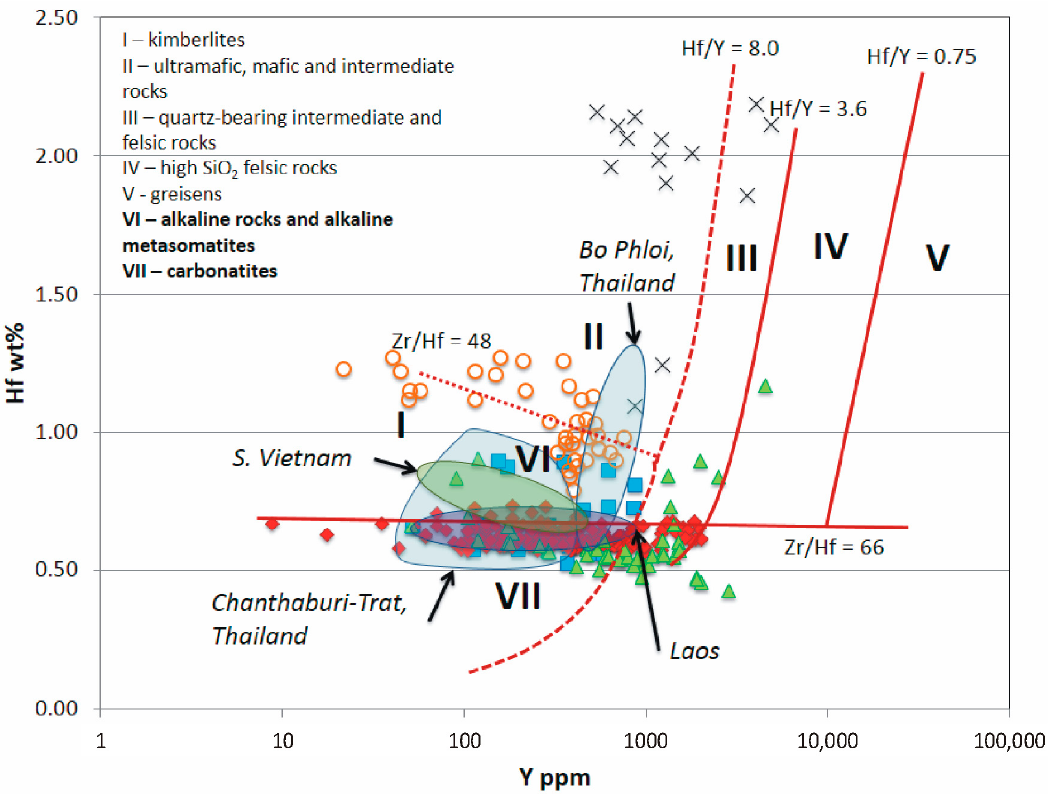
Figure 11. Y versus Hf discrimination diagram for RVP zircon, zircon xenocrysts from ZIP localities, and zircon inclusions in corundum (modified after [92]). Red diamonds: RVP zircon, blue squares: Pailin, Cambodia (Piilonen, unpublished data), blue field: Thailand (Piilonen, unpublished data), green triangles: Australia [11], orange circles: zircon xenocrysts from carbonatites [5], black crosses: zircon inclusions in corundum xenocrysts [10,12,38,97] .